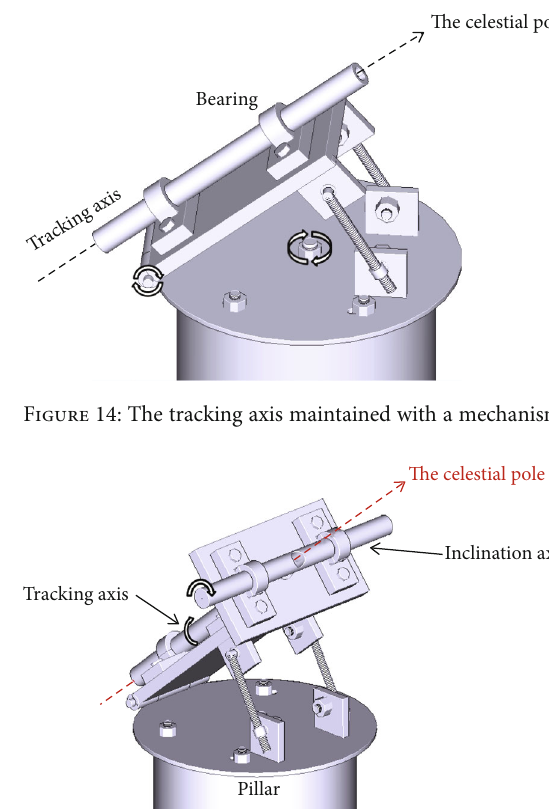
Figure 15: The equatorial mount with the tracking axis and the tilt